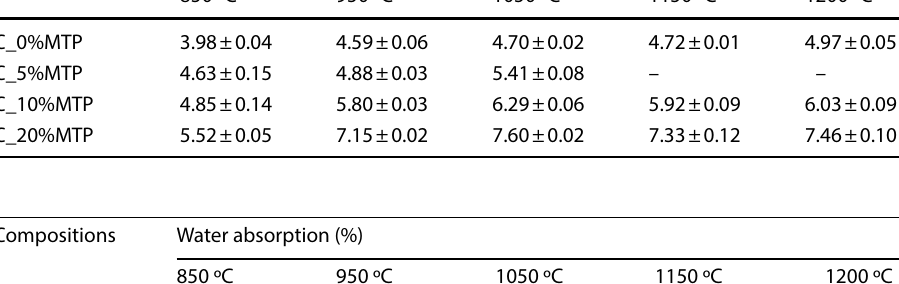
Table 6 Weight loss behavior with the increase of firing temperature to all compositions